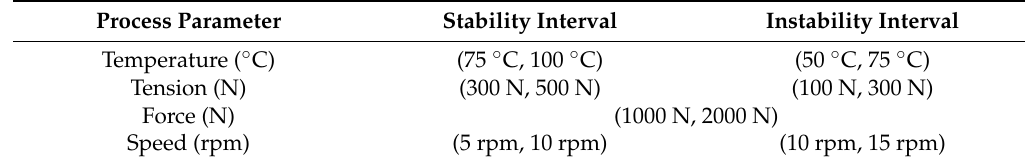
Table 2. Stability and instability interval for process parameters of the tensile strength model.